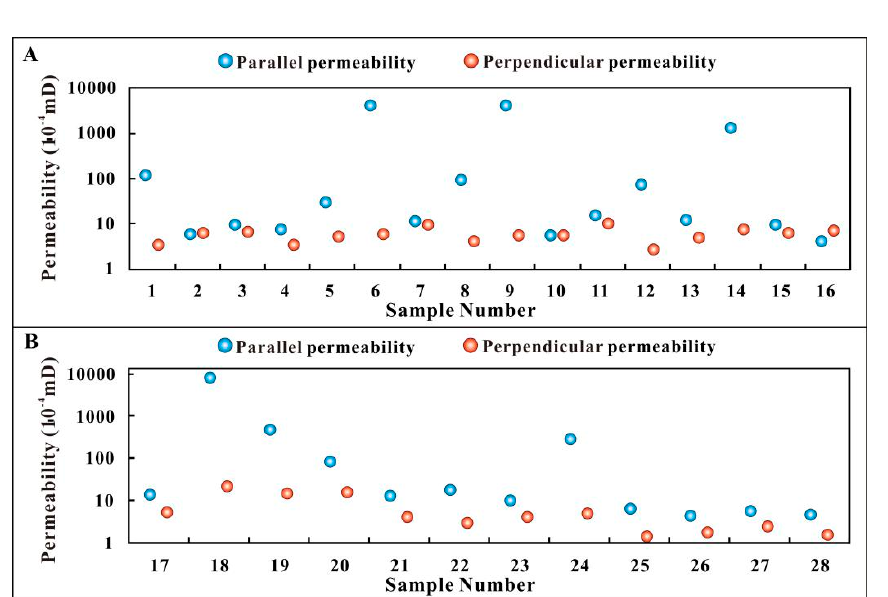
Figure 4. Parallel and perpendicular permeability scattergrams. ( A ) Samples of Wangyinpu and Guanyintang Formations shale from the Jiangye-1 and Jiangye-2 wells; ( B ) samples of Longmaxi Formation shale from the Pengye-1 well. The sample information can be seen in Table 2.